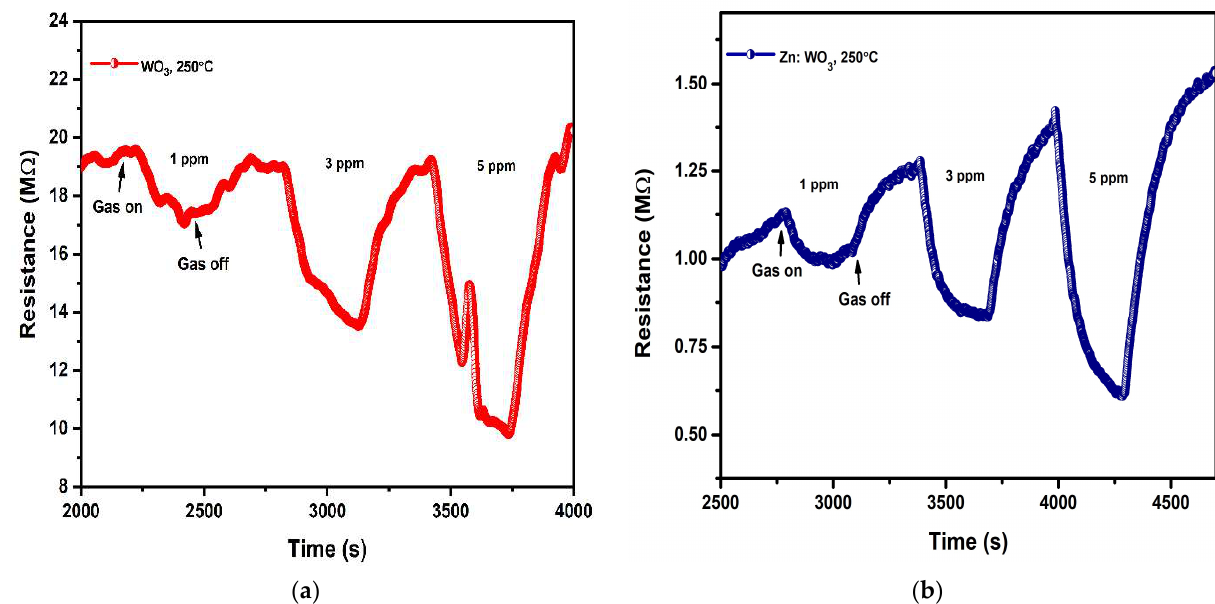
Figure 7. ( a ) Transient response curves of ( a ) WO 3 and ( b ) Zn: WO 3 films.